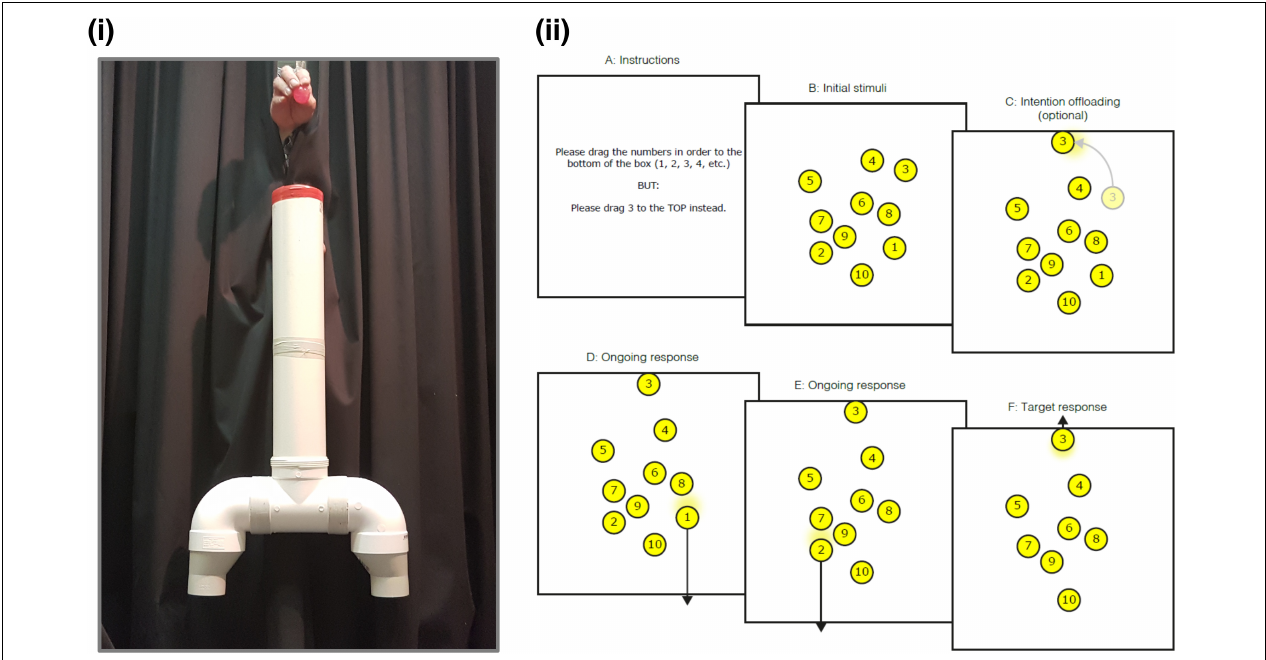
FIGURE 2 | Recent minimalist paradigms for investigating basic mechanisms of prospection. (i) Placing one hand under each opening from the forked tube demonstrates a capacity to prepare for two mutually possible future events, thereby demonstrating the rudiments of advanced ‘contingency planning’ (Redshaw and Suddendorf, 2016). (ii) In a reminder-setting task, participants drag numbered circles in ascending order to the bottom of the box. They must also remember to carry out either one or three alternative actions for specific numbers (dragging them to a particular edge) (A,B) . In some conditions, participants have the option of dragging the target circles to the relevant edge of the box at the beginning of the trial – a reminder setting strategy (C) . If participants do pursue this option, then – after dragging non-target circles to the bottom of the box (D,E) – the new location of the target circles will remind them of the required action (F) (Redshaw et al., 2018). Child Development © 2018 Society for Research in Child Development, Inc. All rights reserved.